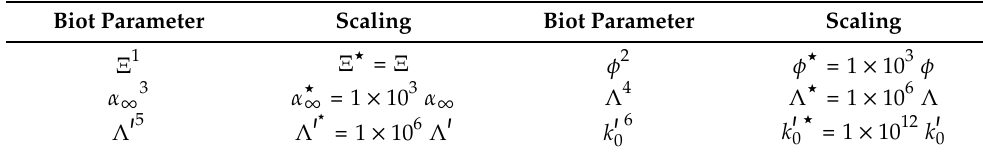
Table 3. Scaling of the Biot parameters to balance out the different